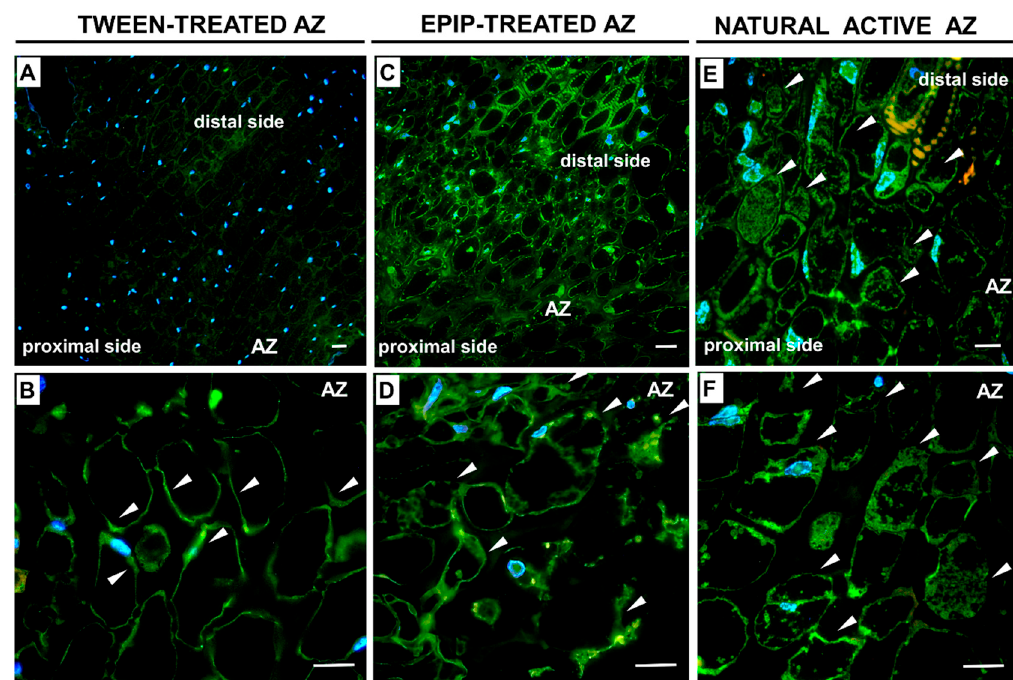
Figure 2. Immunolocalization of MPK6 in the flower AZ of yellow lupine in response to EPIP treatment and the naturally active AZ. EPIP peptide solution (100 µ M) in 0.05% Tween 20 was applied directly on inactive AZ and the plant material was collected 6 h after treatment ( C , D ). Inactive AZ was harvested 6 h after 0.05% Tween 20 solution application ( A , B ). MPK6 was also localized in the naturally active AZ ( E , F ). Photos B , D , and F are magnifications of AZ regions used for analyses presented on A , C , and E . Bar—60 µm ( A ), 100 µm ( B ), 40 µm ( C – F ). Immunofluorescence, green signal indicates MPK6 presence. Nuclei were stained with DAPI (blue fluorescence). Arrows mark signal for MPK6 in the peripheral areas of the cytoplasm ( B ) and in the cell cytosol after cell division ( D – F ). Yellow and orange color corresponds to the cell wall autofluorescence.